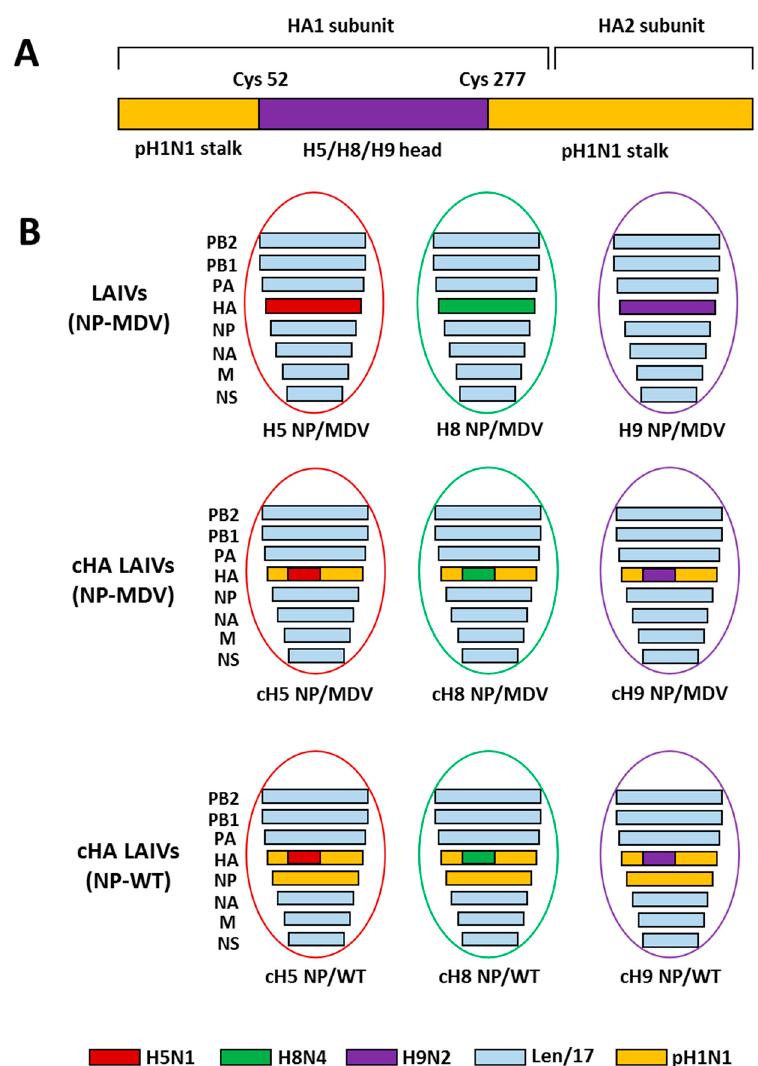
Figure 1. Overview of the LAIV viruses used in this study. ( A ) Schematic representation of the chimeric HA protein structure. ( B ) Genome composition of the LAIV reassortant viruses rescued in this study.